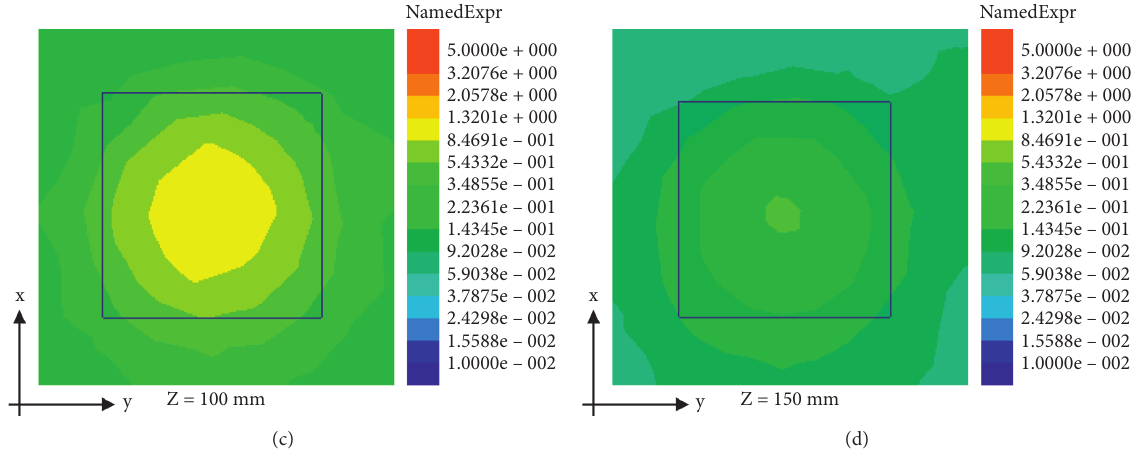
Figure 14: Simulated Ez distributions of the three-branch antenna at different heights when the substrate thickness h � 1.5mm. (a) Z � 30 mm. (b) Z � 50mm. (c) Z � 100mm. (d) Z � 150mm.